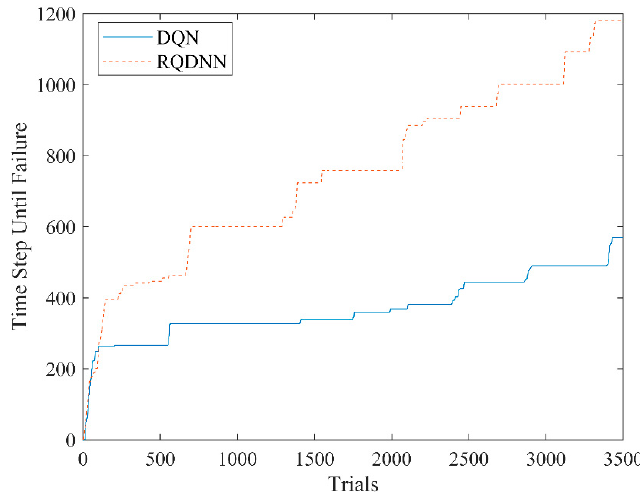
Figure 17. Comparison results of RQDNN and DQN [2] in the Breakout game.